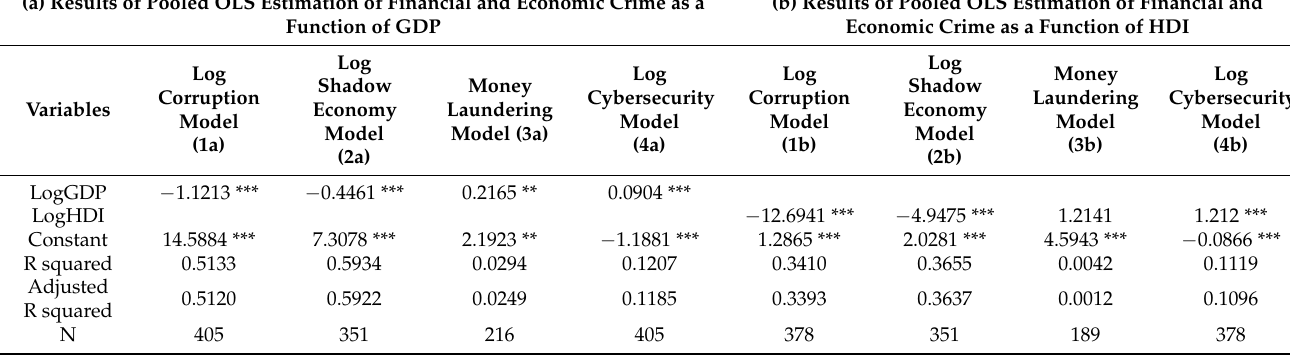
Table 1. Simple regression